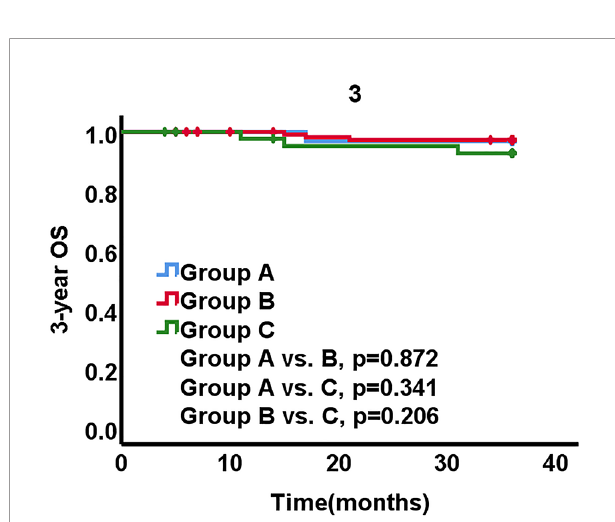
FIGURE 2 | Distant metastasis free survival (DMFS) strati fi ed by three